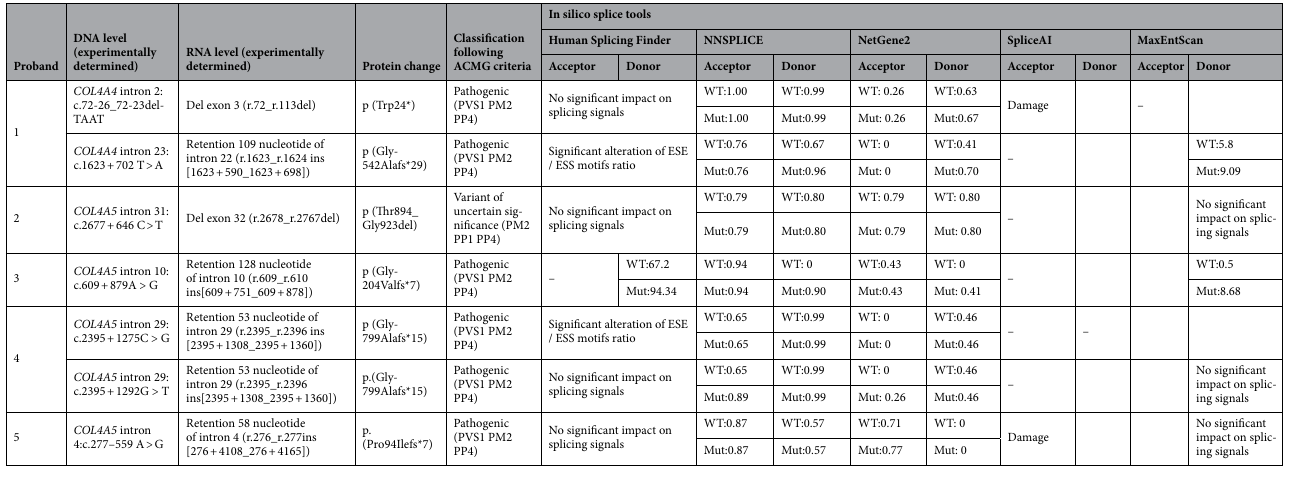
Table 2. The output of in silico splice tools for deep intronic pathogenic variants detected in this study. Variants were named following Human Genome Variation Society guidelines (http:// www. hgvs. org/ mutno men). For genomic DNA positioning, numbering was based on the reference sequences (chr2:227,007,325– 227,147,483 for COL4A4 gene and chrX:108,440,126–108,696,378 for COL4A5 gene), whereas RNA position was numbered according to the reference sequences (NM_000092.5 for COL4A4 mRNA and NM_000495 for COL4A5 mRNA) using the first coding ATG of exon 1 as the initiation codon. ACMG the American